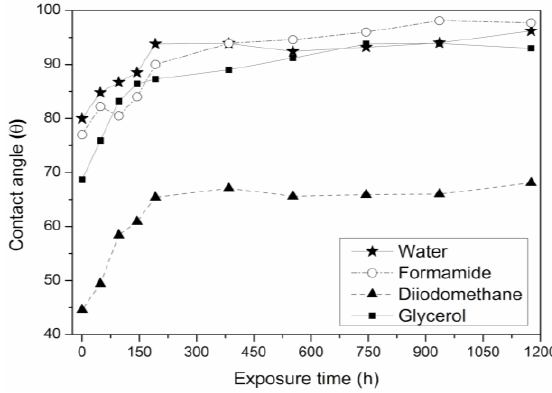
Figure 6. Variation of the contact angle (θ) on SEBS surface for different test liquids versus UV exposure time.